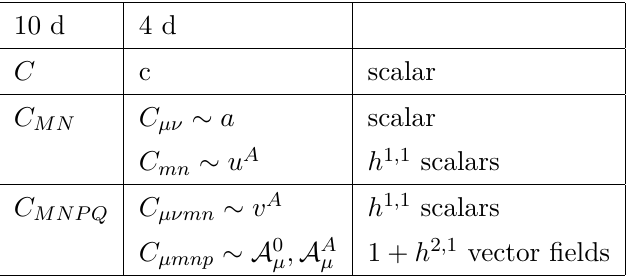
Table 11 . Massless fields in type-IIB Calabi-Yau compactifications, R-R